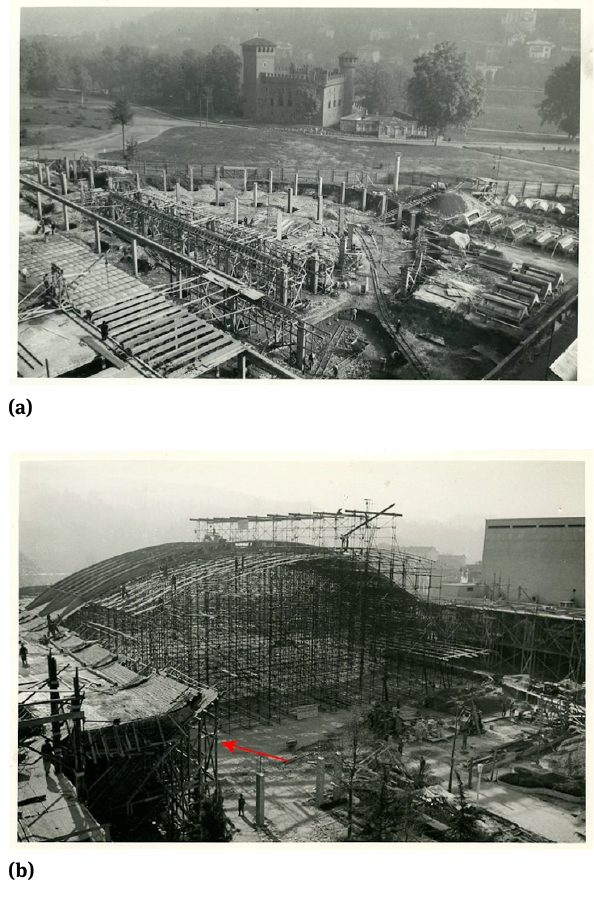
Figure 2: (a) A picture showing the initial stage of the construction site of hall B, which started from the apse. It is also possible to notice the prefabricated elements in ferrocement built simultane- ously. (b) Advancement of the construction site, in which the red arrow indicates a pillar that has not been cast yet, while the ones closer to the apse are in a more advanced stage (photos by Riccardo